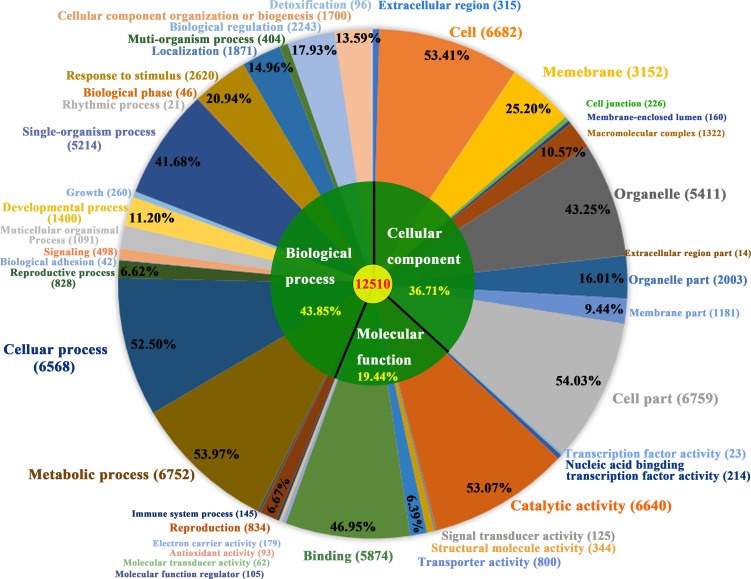
Gene Ontology classification.Genes were assigned to three categories: cellular components, molecular functions and biological process.